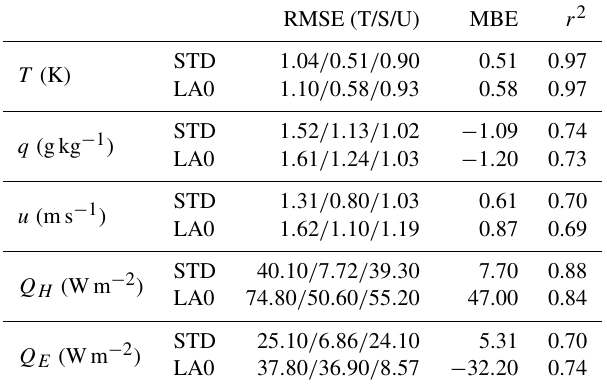
Table 4. RMSEs, MBEs and coefficient of determination ( r 2 ) of the simulated air temperatures ( T ), specific humidity ( q ), wind speed ( u ), sensible heat flux ( Q H ) and latent heat flux ( Q E ) at the BKLI site (38m above ground) during the study period. In addition to the total RMSEs (T), the systematic (S) and the unsystematic (U) RM- SEs are listed. The statistics are provided for the standard simulation (STD) and the simulation without street trees (LA0). The units only apply to RMSE and MBE.